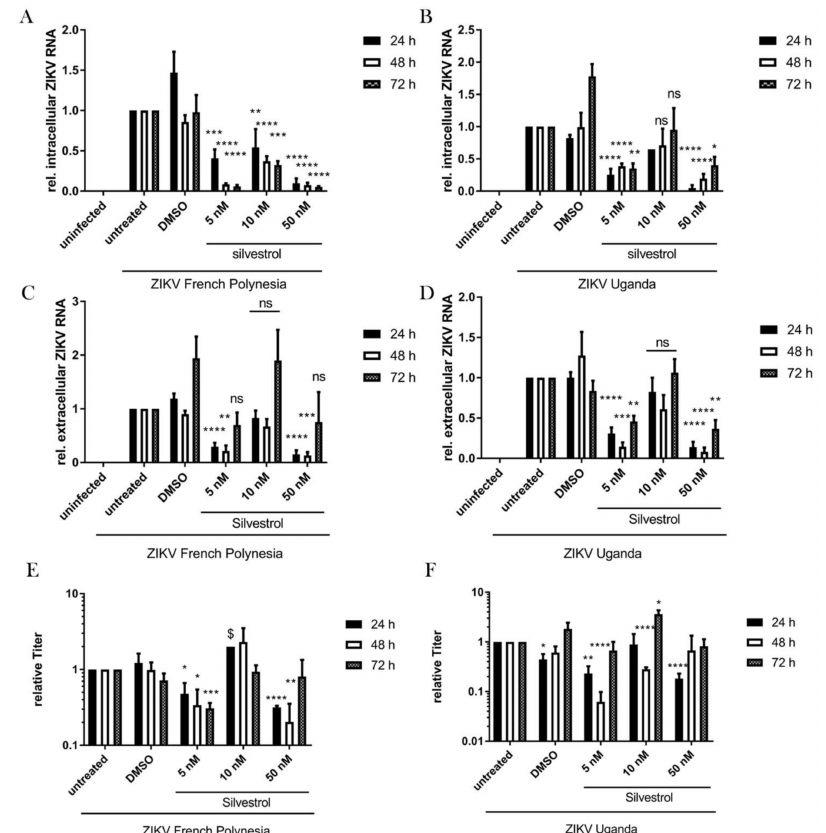
Figure 3. Significant reduction of intra- and extracellular ZIKV RNA levels and released virions. ( A ) Quantification of intracellular ZIKV RNA of A549 cells infected with ZIKV FP and treated with the indicated concentrations of silvestrol. ZIKV RNA was quantified by RT-qPCR and normalized to the amount of RPL27 transcripts; ( B ) Quantification of intracellular ZIKV RNA of A549 cells infected with ZIKV U and treated with the indicated concentrations of silvestrol. ZIKV RNA was quantified by RT-qPCR and normalized to the amount of RPL27 transcripts; ( C ) RT-qPCR quantification of extracellular ZIKV RNA of A549 cells infected with ZIKV FP and treated with the indicated concentrations of silvestrol; ( D ) RT-qPCR quantification of extracellular ZIKV RNA of A549 cells infected with ZIKV U and treated with the indicated concentrations of silvestrol; ( E ) Relative extracellular titers of A549 cells infected with ZIKV FP and treated with the indicated concentrations of silvestrol. Titers were quantified by plaque assay in Vero cells; ( F ) Relative extracellular titers of A549 cells infected with ZIKV U and treated with the indicated concentrations of silvestrol. Titers were quantified by plaque assay in Vero cells. $: only two experiments were performed. ns = not significant = p > 0.05; * = p ≤ 0.05; ** = p ≤ 0.01; *** = p ≤ 0.001; **** = p ≤